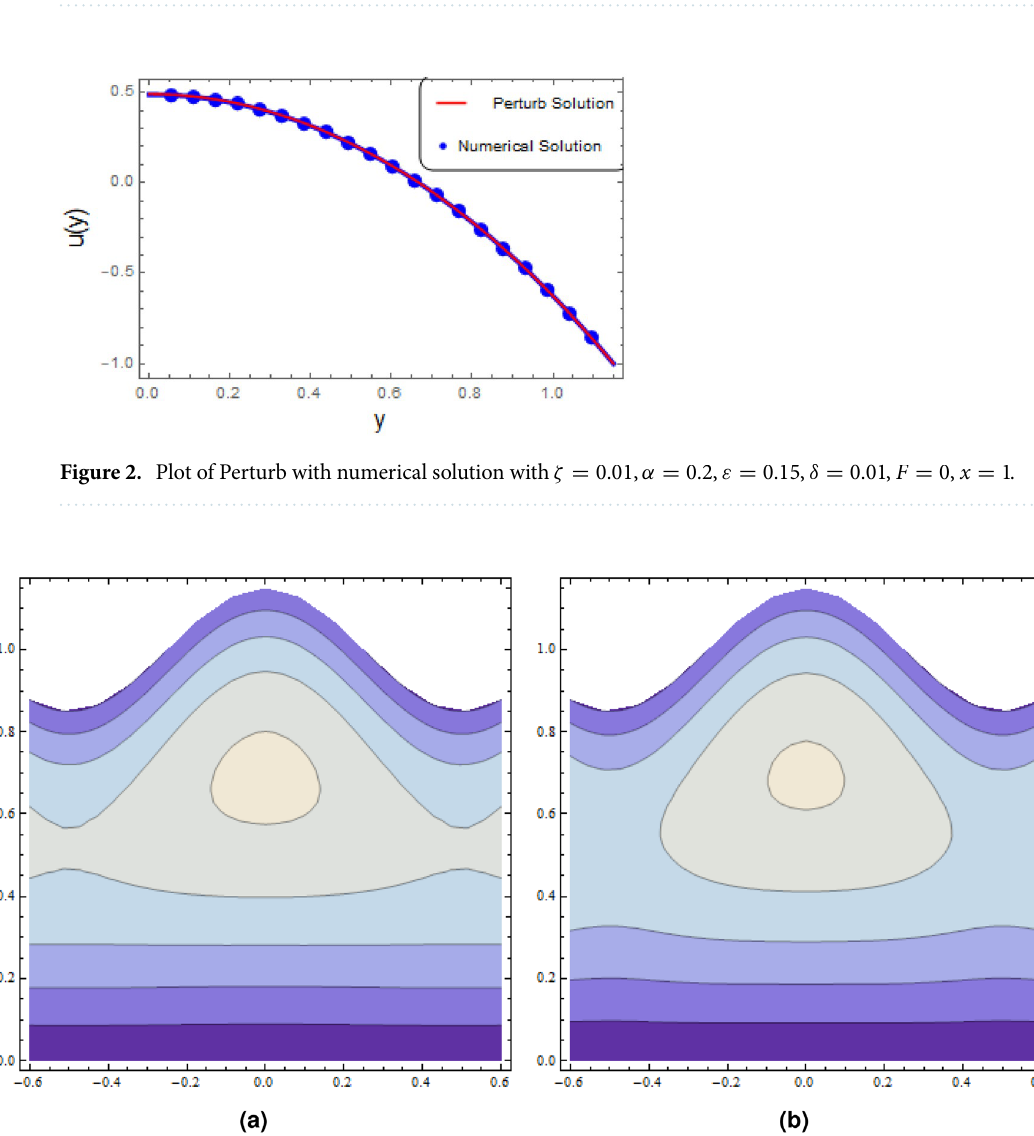
Table 2. Shows analysis of Perturb solution with numerical solution for stream function with α = 0.2, ε = 0.15, δ = 0.01, F = 0.1, x = 1 .